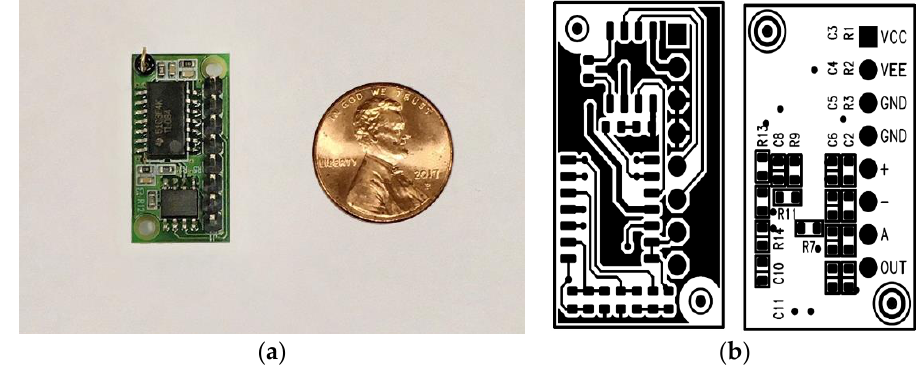
Figure 1. Development of electromyogram (EMG) detection system ( a ), top and bottom Gerber file ( b ). The manufactured module has a size of 15 × 25 × 2 mm 3 and can measure one channel signals at the same time.